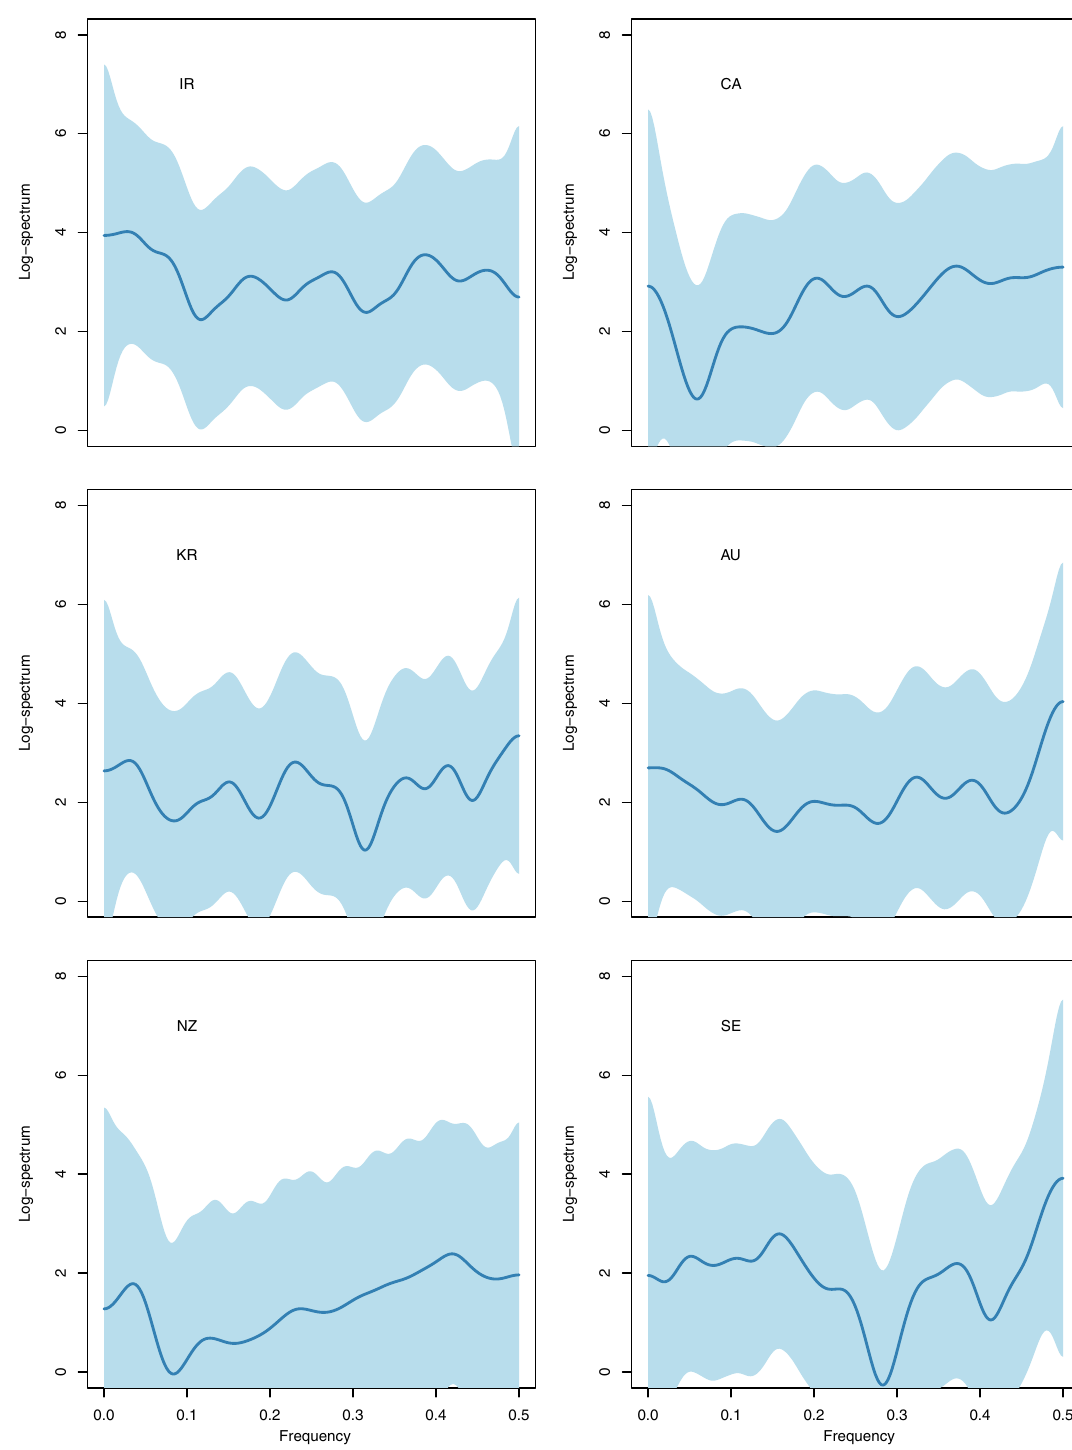
Figure 9. Regspec spectral estimates for numbers of new daily COVID-19 cases. Top-to-bottom, left-to-right: Iran on 55 days, Canada on 49 days, South Korea on 56 days, Australia on 54 days, the New Zealand on 28 days, Sweden on 47